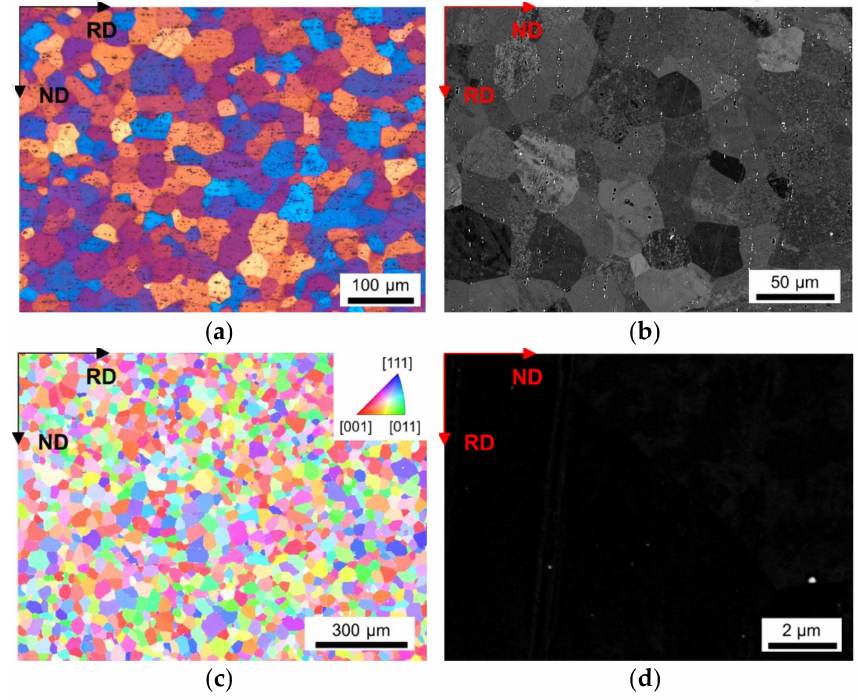
Figure 2. Microstructure of the soft annealed LFe-LMn cast under NR-C condition, homogenized at 500 ◦ C and cold rolled to a CRD of 35%. ( a ) LOM. ( b ) BSE image. ( c ) EBSD IPF map in RD–ND plane. ( d ) BSE micrograph showing dispersoids.